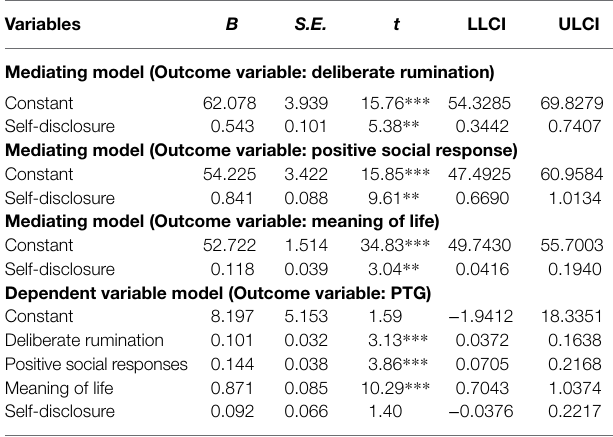
TABLE 2 | Parallel multiple mediating effects of deliberate rumination, positive social responses, and meaning of life on self-disclosure and